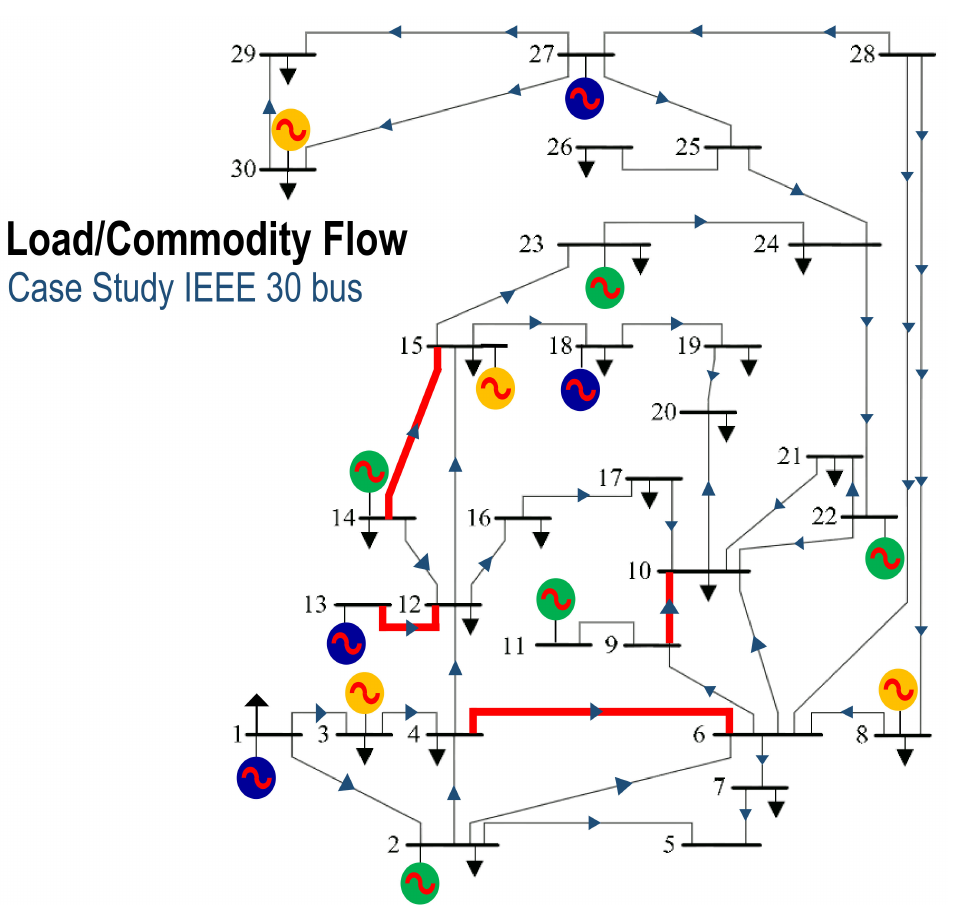
Figure 3. Load flow for base case IEEE 30 bus power